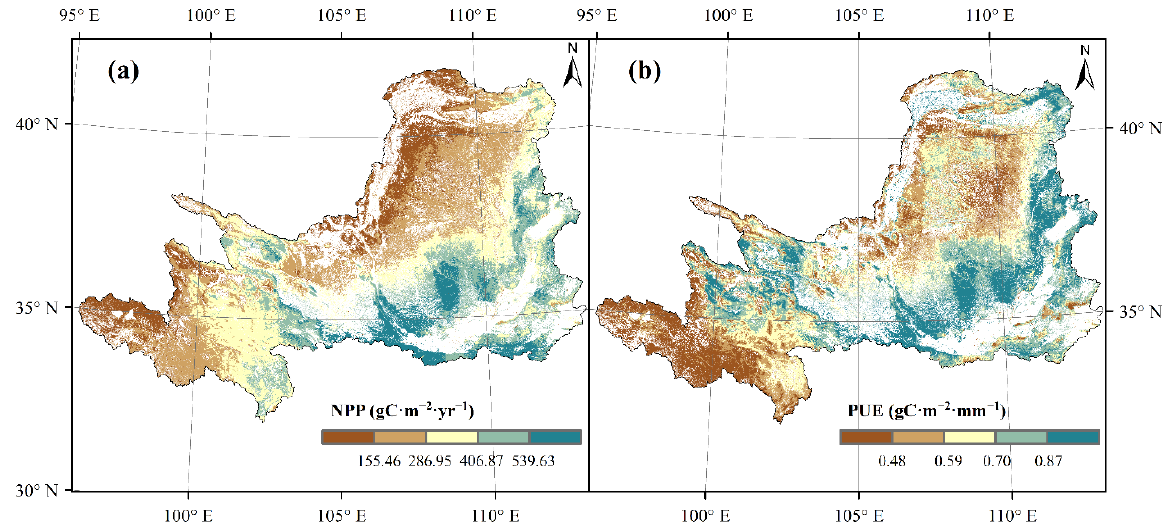
Figure 3. Spatial patterns of ( a ) NPP and ( b ) PUE of forest, shrub land and grassland across the YRB.